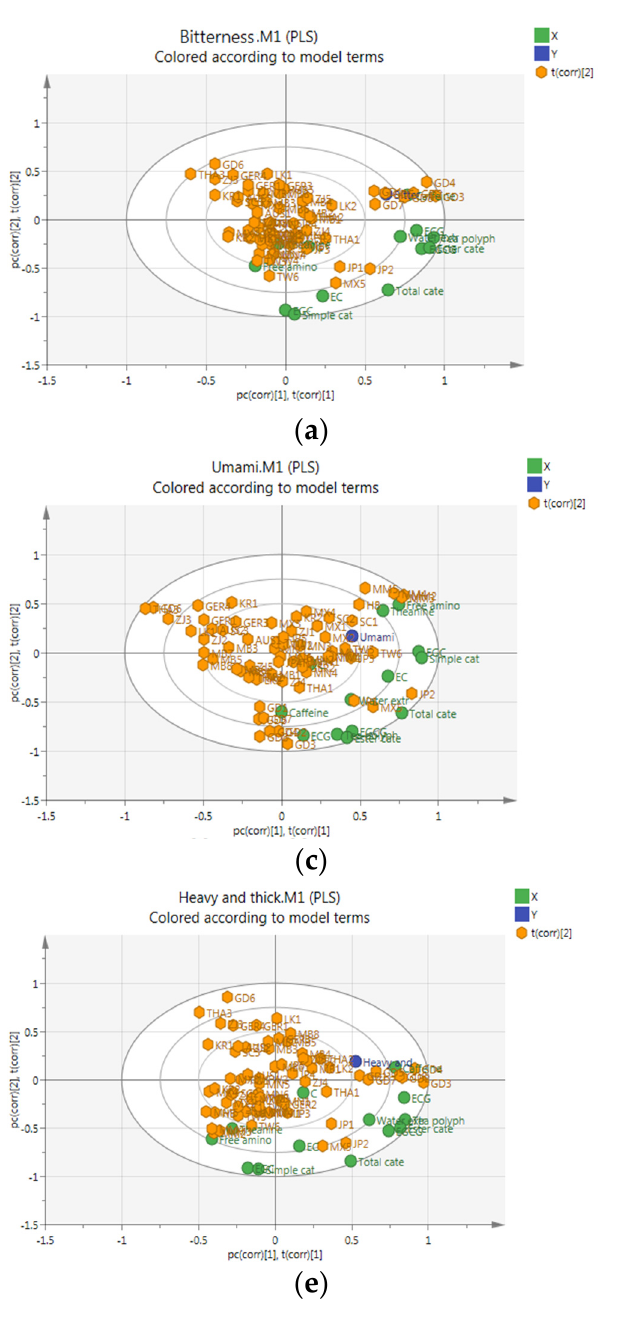
Figure 5. The contribution of phytochemical components to taste sub-attributes of Oolong tea. PLS- VIP load diagram of ( a ) bitterness; ( b ) astringency; ( c ) umami; ( d ) sweet aftertaste; and ( e ) heavy and thick. ( f ) VIP value of each phytochemical component for five taste sub-attributes. ( a ) to ( e ), X (green) indicates the phytochemical composition, Y (blue) indicates the taste powder attribute, and t(corr) [2] (yellow) indicates each Oolong tea sample. ( f ) Red and blue indicate that the VIP value of phytochemical components is large and small, respectively.